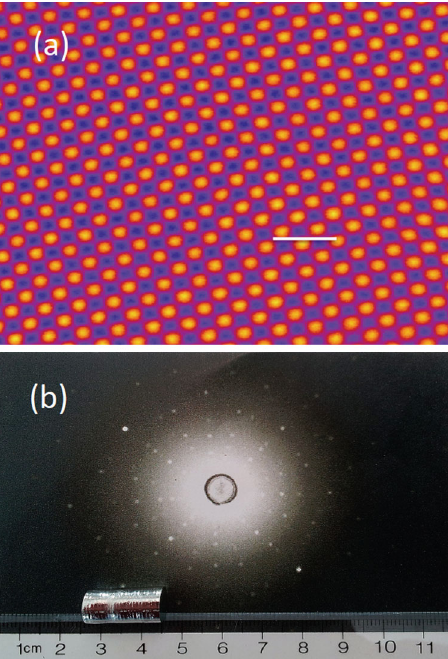
Fig. 1 Homogeneous NiCoCr x Crystals a STEM image of columns of atoms along the [100] direction from a NiCoCr single crystal. These images and associated EELS (electron energy loss spectroscopy) data taken at the same time do not detect any evidence of elemental clustering or ordering. Each “ atom ” in the fi gure is actually a column of atoms about 20 nm in length. The white scale bar corresponds to 0.5 nm. Clustering of Cr atoms would, for example, produce regions of lower image intensity. The distance between columns is approximately 0.18 nm, and this would also vary if signi fi cant clustering occurred. The images were obtained using a Nion UltraSTEM200 operated at 200 kV with an illumination half- angle of 30 mrad and an inner detector half-angle of 65 mrad. b Laue X-ray image from a 10 g NiCoCr 0.8 crystal shown at the bottom